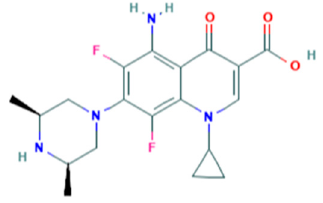
Figure 1. Structure of sparfloxacin.